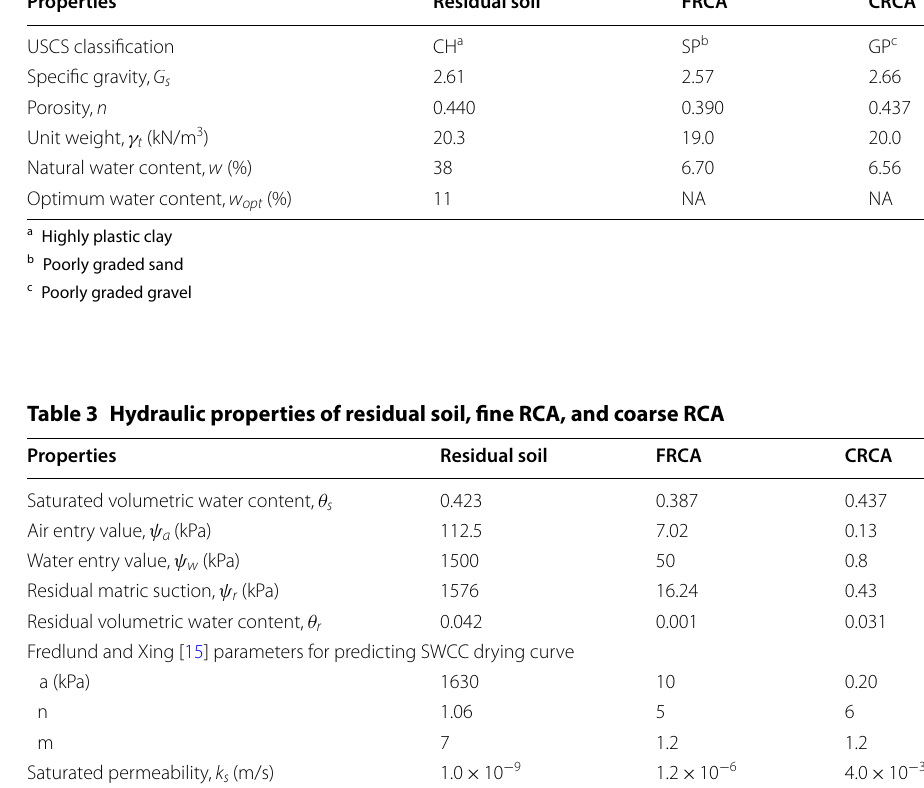
Table 2 Index properties of residual soil, fine RCA, and coarse RCA